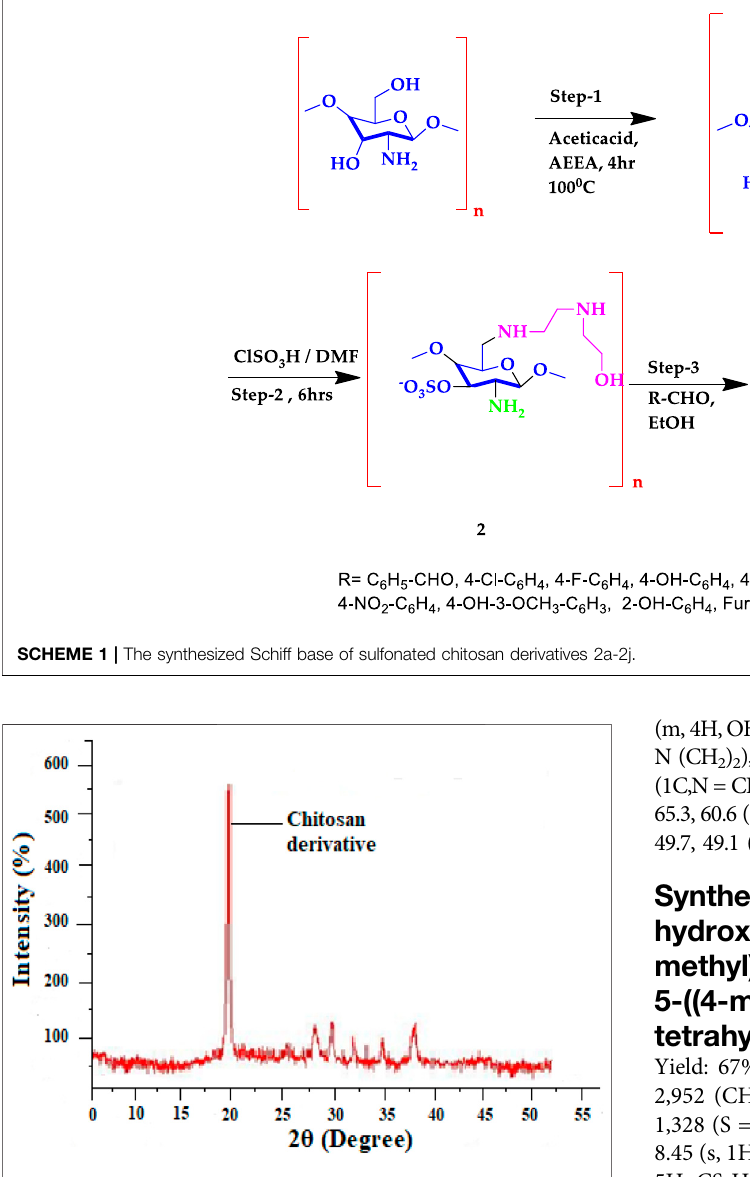
Frontiers in Chemistry |